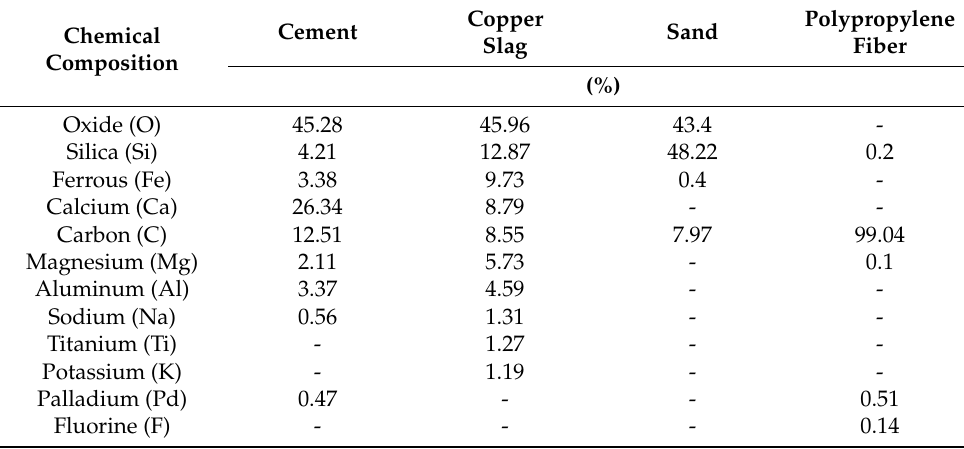
Table 2. Chemical composition of materials